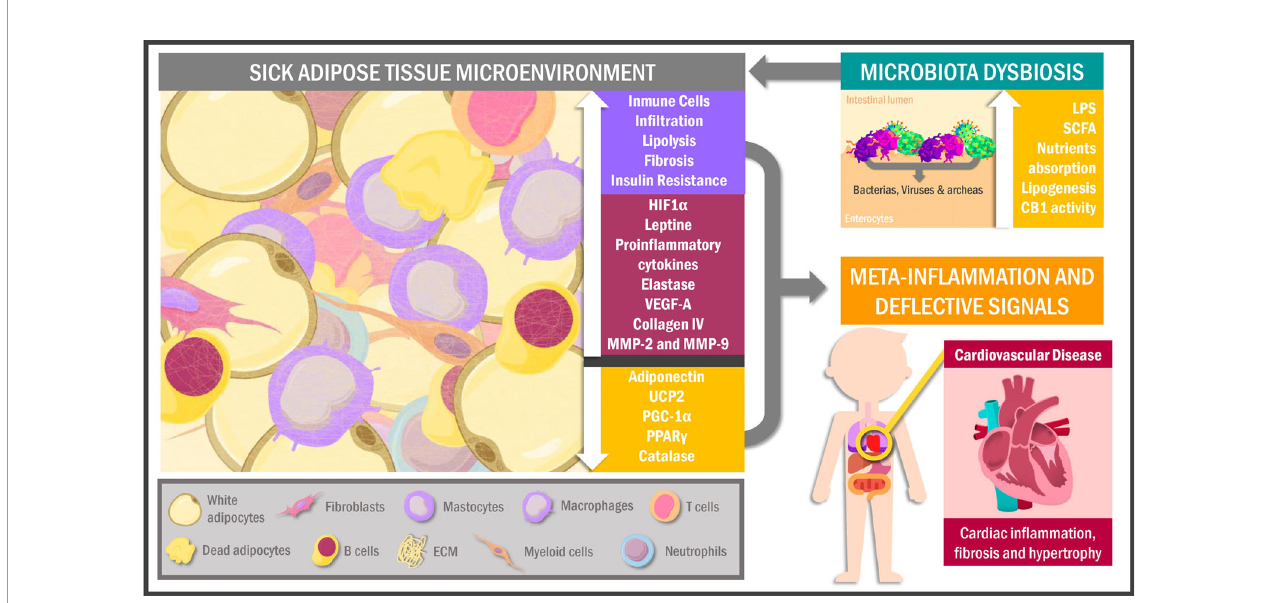
FIGURE 1 | Sick adipose tissue microenvironment and its interactions. Hypertrophic adipocytes and immune cells in fi ltration characterize the adipose tissue of obese individuals in response to a hypoxic environment as a signal for cell death and in fl ammation. This phenomenon leads to proteomic dysregulation and de fl ective peripheral signals promoting metabolic alterations in other tissues like muscle cells, particularly the myocardiocytes. In addition, obesogenic habits in overweighed people cause changes in the intestinal microbiota triggering adipose tissue chronic in fl ammation and cellular senescence. UCP2, uncoupling protein 2; PGC-1 a , peroxisome proliferator-activated receptor gamma coactivator 1 a ; PPAR g , peroxisome proliferator-activated receptor gamma; VEGF-A, vascular endothelial growth factor A; MMP, metalloproteinases; HIF1 a , hypoxia-inducible factor 1 a ; LPS, lipopolysaccharides; SCFA, short-chain fatty acids; CB1, cannabinoid receptor 1; ECM, extracellular